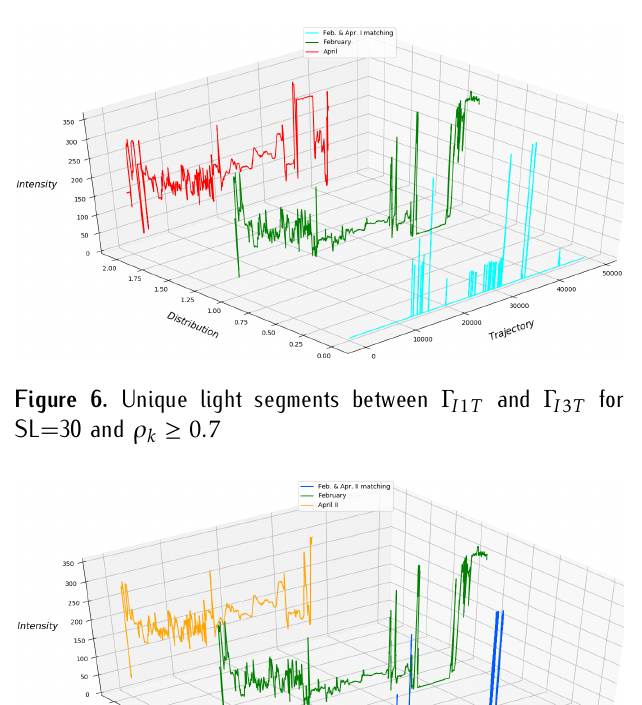
and Γ for I 1 T I 4 T Figure 10. Virtual probable light signatures for trajectory Deva to Timis oara with SL=30 and ρ ,